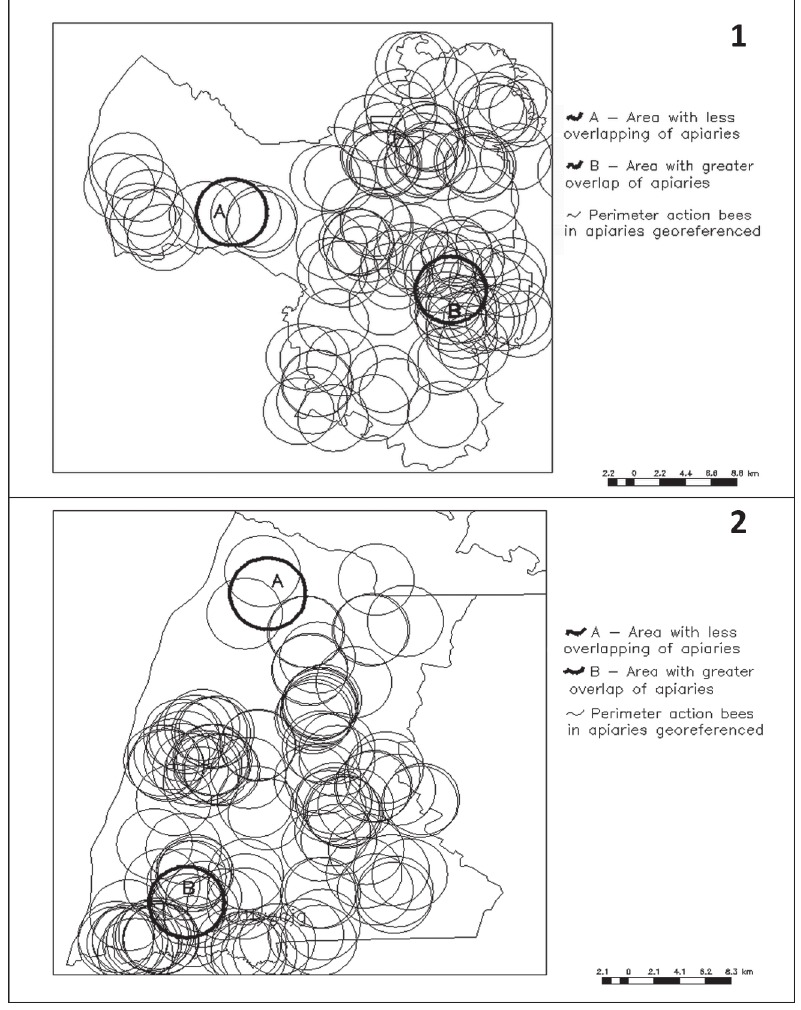
Figure 1 - Apiaries geo-referenced in 2010 in the counties of Marechal Cândido Rondon - MCR (1) and Santa Helena - SH (2), with the areas chosen for the study